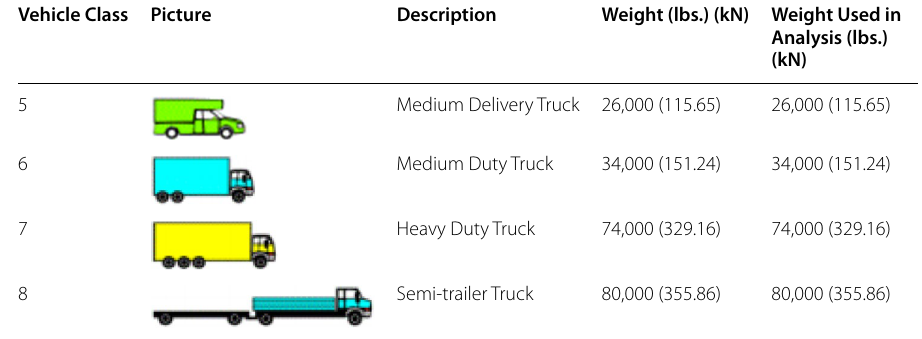
Table 1 Classification of vehicle categories (AFDC 2018) Vehicle Class